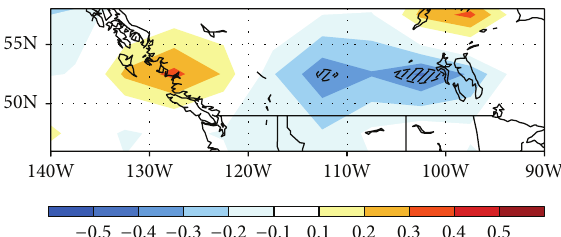
Figure 11: Correlation of EIS index with cyclone track frequency for JAS from 1979–2009. Hatched regions are significant at